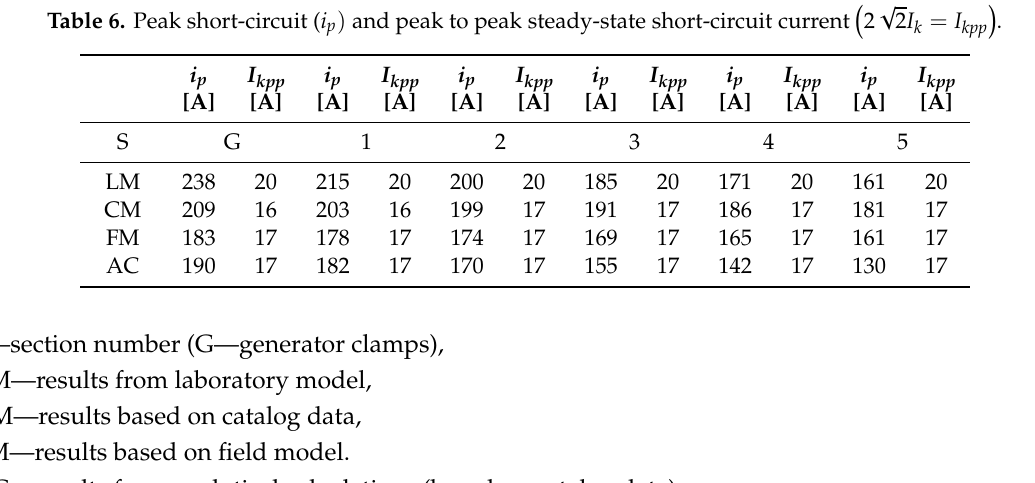
Figure 9 . Comparison of short-circuit currents and the rotor speed of the generator at the generator clamps and after the fifth line section.